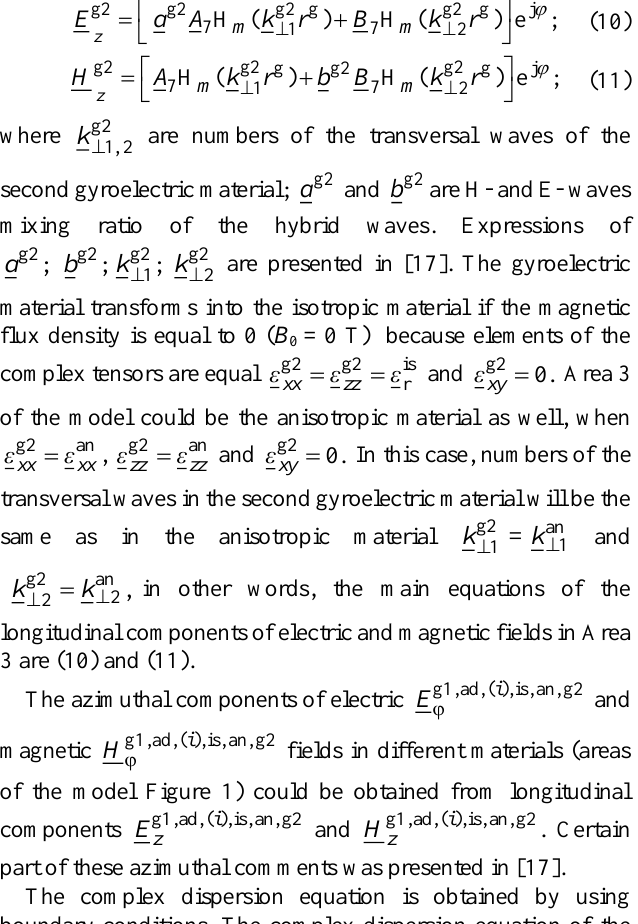
model of open cylindrical multilayer gyroelectric-anisotropic- gyroelectric waveguides (Fig. 1) is air and its permittivity and permeability are equal to